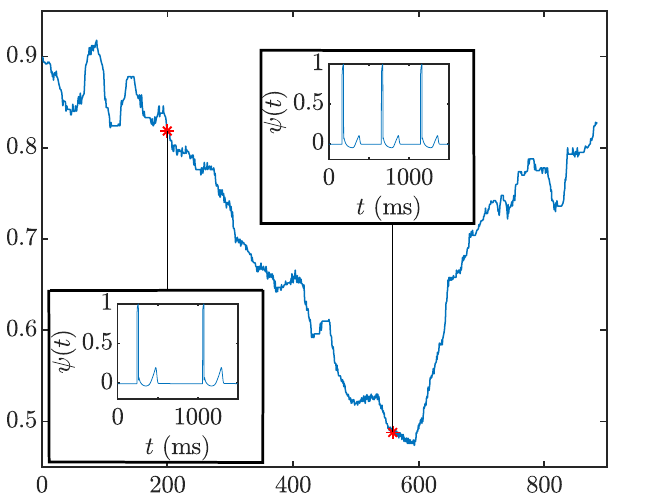
Fig 1. Main panel: d RR ( n ) time series, in seconds, from the analyzed ECG recording of a CAD patient. Insets: normalized pECG signals, ψ ( t ), computed from the simulated transmembrane potentials of the tissue fiber at two time